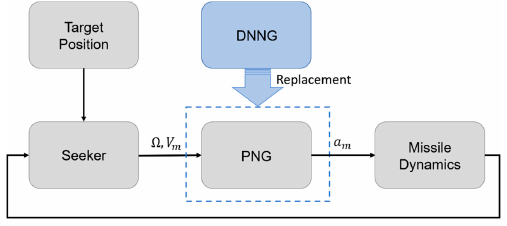
Figure 4. Schematic diagram of the missile system.